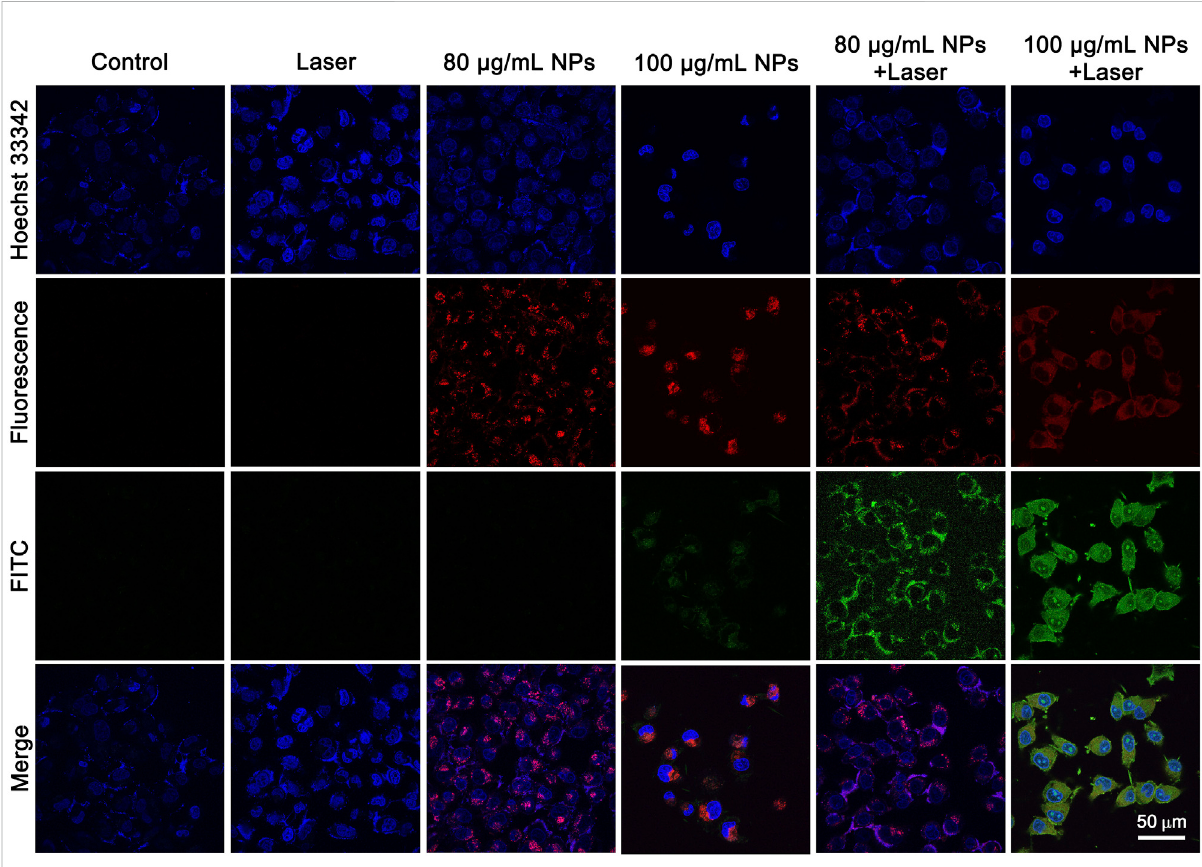
FIGURE 6 CLSMimagesofHeLacellstreatedwithDMEMonly,IR820@PDA@PEGNPsonly,laseronly,andIR820@PDA@PEGNPspluslaser(793 nm,1 W/ cm 2 , 8 min) after stained by Hoechst 33342 and annexin V-FITC. λ ex = 488 nm (Hoechst 33342). λ ex = 488 nm (FITC). Images were obtained at a ×60 objective. Scale bar = 50